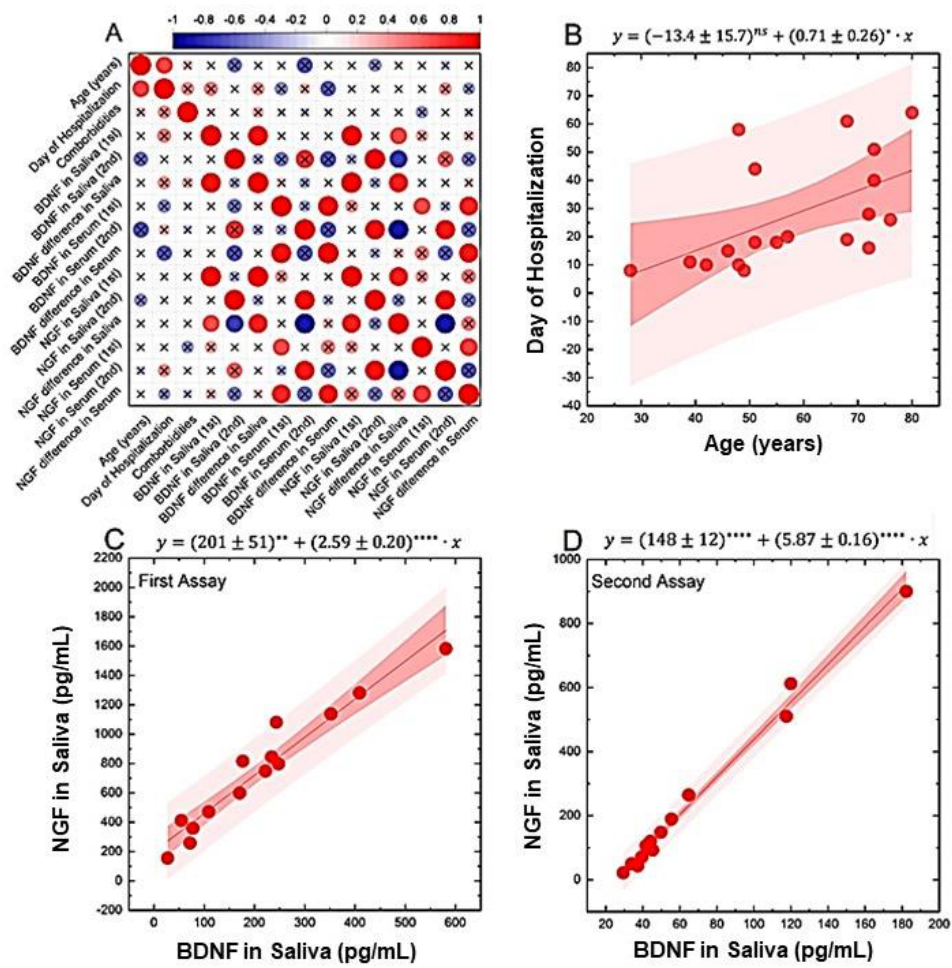
Figure 3. Comparisons between demographic and biochemical data. ( A ) Matrix map of selected laboratory and demographical variables. Correlations between variables were analyzed with Spear- man’s correlation coefficients, and non-significant correlations are highlighted with an “x” symbol. A double color scale is used to visualize the strength and the direction of correlations: blue dots indicate the presence of negative correlations, while red dots point to positive correlations. Finally, larger dots highlight stronger correlations. ( B – D ) Scatter plot analysis of data leading to selected significant correlations: ( B ) days of hospitalization vs. age; ( B ) NGF vs. BDNF salivary levels in acute phase; and ( C ) NGF vs. BDNF salivary levels in remission phase. Data in scatter plots were analyzed using a linear regression model. The best regression line is superimposed on each plot together with confidence and prediction bands. Additionally, the best-fitted equation is reported on each scatter plot with the statistical significance of each retrieved fitting parameter (ns: p > 0.05; *: p ≤ 0.05; **: p ≤ 0.01; ****: p ≤